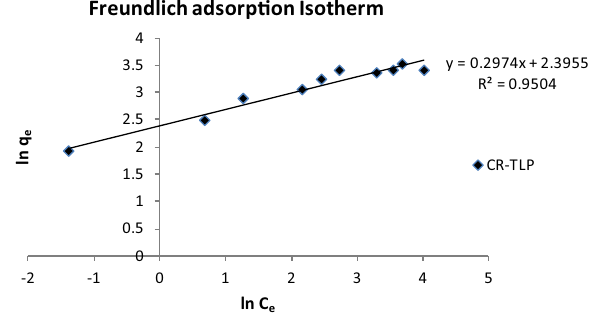
Fig. 14 Freundlich adsorption isotherm model. Temperature—30 °C, concentration—20 ppm, adsorbent dose—150 mg, pH—6, vol- ume—100 ml